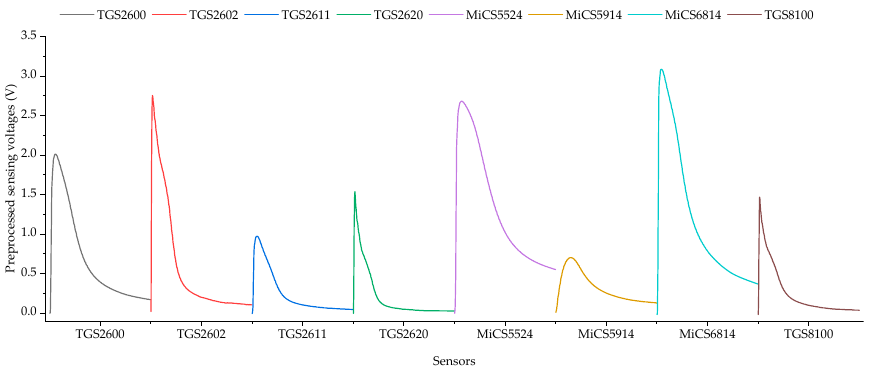
Figure 4. The flattened 1D vector yielded by concatenating the preprocessed measurements of the eight gas sensors in SMUENOSEv2.